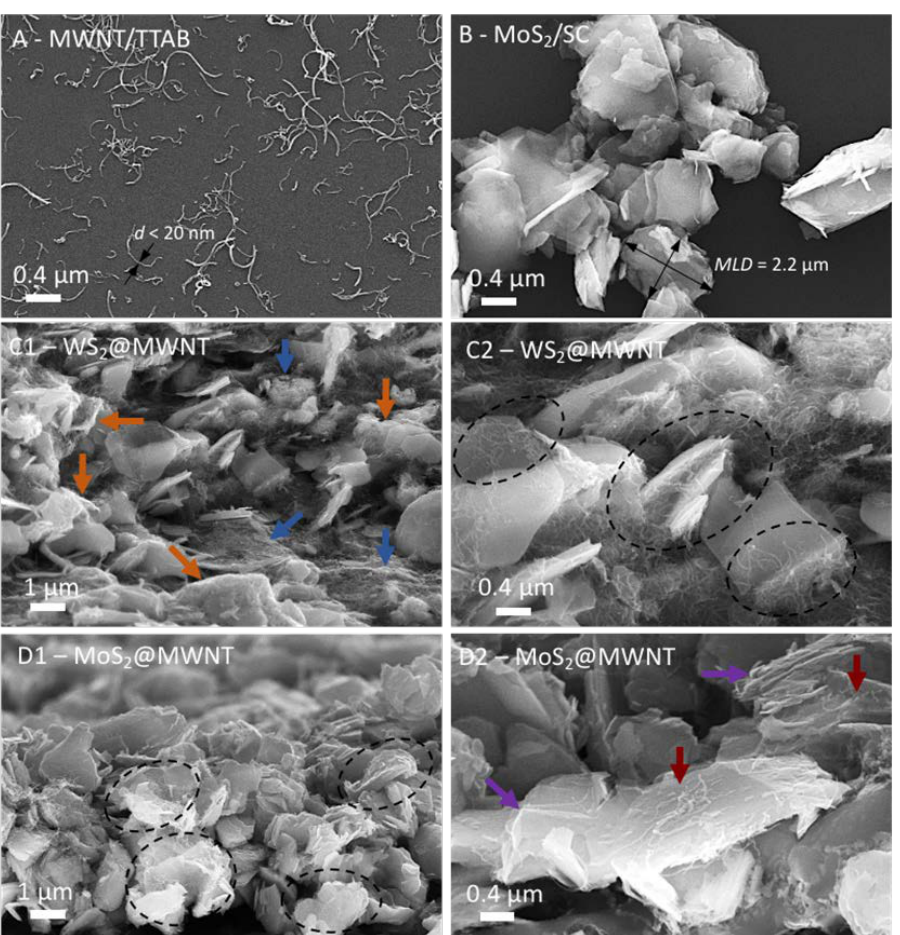
Figure 2. Scanning electron microscopy (SEM) micrographs of the nanocomposite films: ( A ) well- dispersed MWNTs using surfactant TTAB, with arrows showing typical tube widths (<20 nm). ( B ) MoS 2 particles dispersed by surfactant SC, with the calculation of a typical mean lateral dimension ( MLD ) illustrated. ( C1 ) and ( C2 ), WS 2 @MWNT composites, ( D1 ) and ( D2 ), MoS 2 @MWNT compo- sites. The arrows and dashed ovals in C1–D2 highlight particular features described in detail in the text.